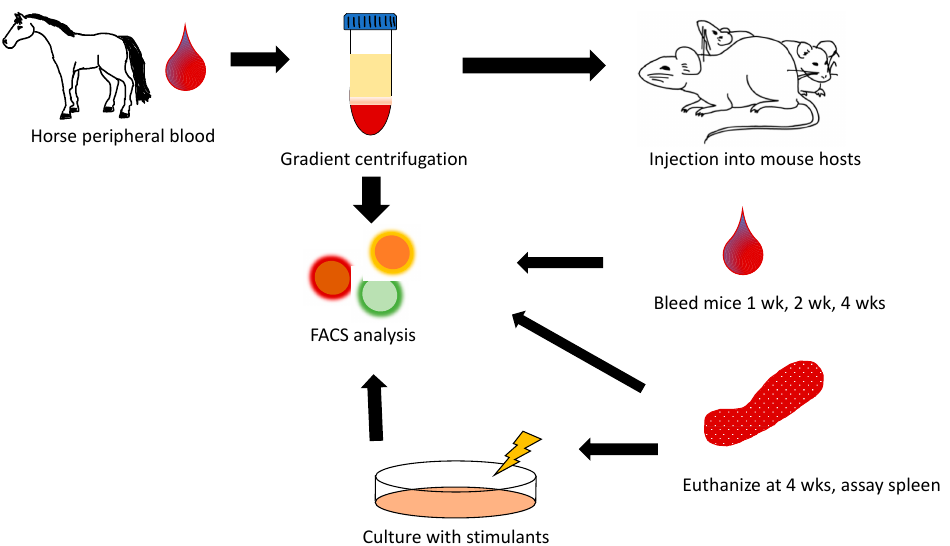
Figure 1. Diagram of experimental design for equine peripheral blood lymphocyte transfer into NSG mouse recipients. On day 0, equine peripheral blood was harvested from three donors. Gradient was centrifuged to separate out lymphocytes, counted and characterized for lymphocyte subsets, and injected IP at 5–10 × 10 6 cells into each of 2 NSG hosts per donor horse. Mice were followed at day 7, 14, and 28 via peripheral blood analysis and sacrificed at 28 days. Splenic cellular analysis was then performed as well as cell culture with phorbol myristate acetate (PMA)/ionomycin stimulation. Cultured cells were analyzed on day 30 via flow cytometry. Wks = weeks, FACS = fluorescence activated cell sorting or flow cytometry.